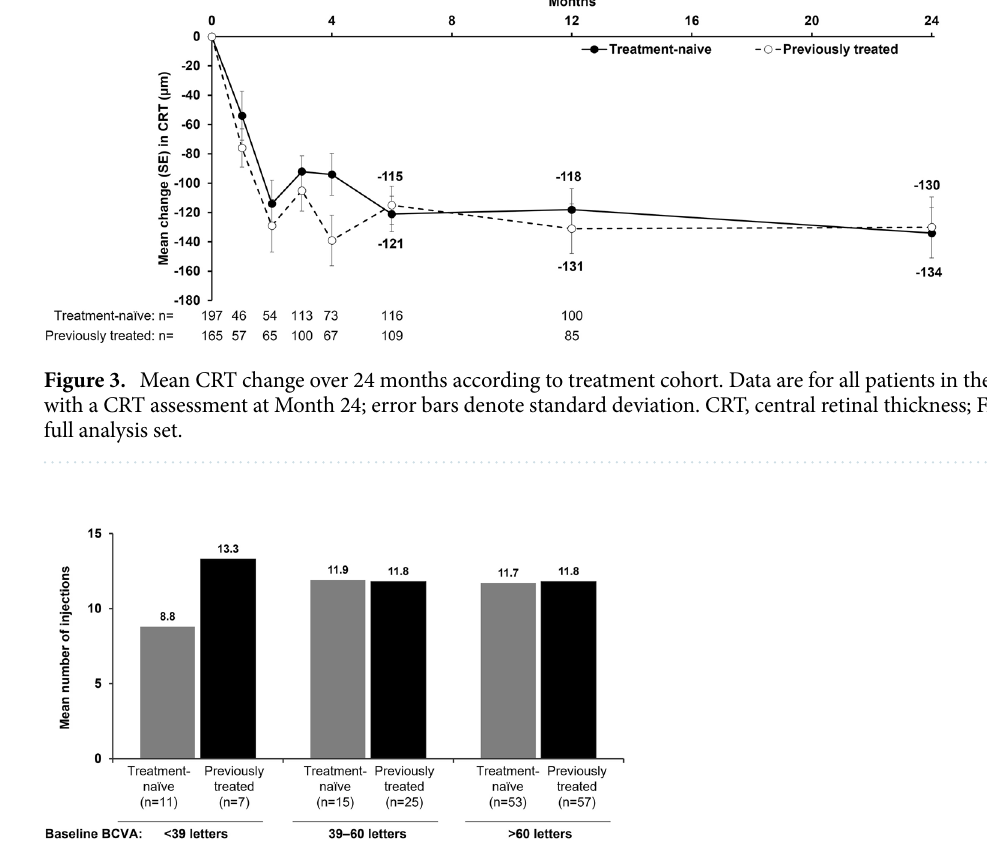
Figure 4. Number of injections received over 24 months according to baseline BCVA and treatment cohort in the overall FAS. Data are for all patients in the FAS with follow-up data on treatment exposure available to at least 23 months (i.e., with an injection between 23 and 25 months from the first IVT-AFL treatment). BCVA, best-corrected visual acuity; FAS, full analysis set; IVT-AFL, intravitreal